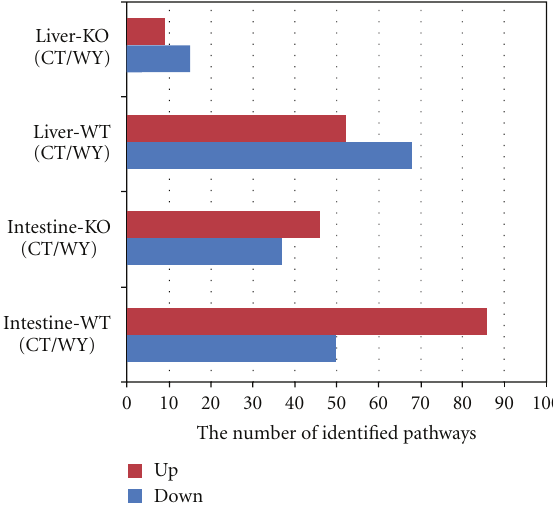
Figure 3: The number of identified up-or downregulated pathways in other four studies of PPAR α -independent side or WY14643- dependent side. The bar chart showing the number of significantly identified pathways ( P ≤ 0 . 01) in additional four studies of PPAR α -independent side or WY14643-dependent side according to the data of Additional File 1. X -axis represents the number of significantly identified pathways; Y -axis represents our four studies. The studies of Intestine-WT (CT/WY) and Liver-WT (CT/WY) are for identifying WY14643-dependent pathways; the studies of Intestine-KO (CT/WY) and Liver-KO (CT/WY) are for identifying PPAR α -independent pathways, respectively, in mice small intestine and liver. Red color (up) is for upregulated pathways and blue color (down) is for downregulated pathways. There were 86 and 50 in study of Intestine-WT (CT/WY), the study in mouse wild type intestine of comparison between with normal food and with the treatment of WY14643 in GSE5475; 46 and 37 in study of Intestine-KO (CT/WY), the study in mouse PPAR α -null intestine of the comparison between with normal food and with the treatment of WY14643 also in GSE5475; 52 and 68 in study of Liver-WT (CT/WY), the study in mouse wild type liver of comparison between with normal food and with the treatment of WY14643 in GSE8295; And 9 and 15 in study of Liver-KO (CT/WY), the study in mouse PPAR α -null liver of the comparison between with normal food and with the treatment of WY14643 also in GSE8295, respectively, for up-and downregulated pathways.